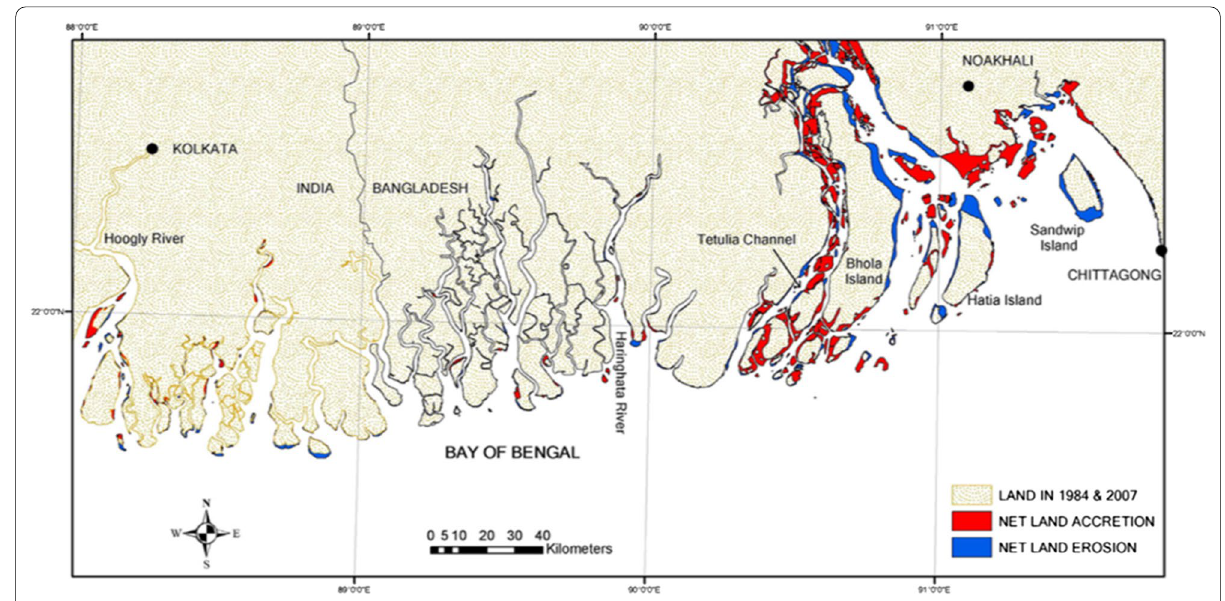
Fig. 2 Gains and losses of land on the Brahmaputra–Ganges–Meghna delta front in 1984–2007 (after Brammer